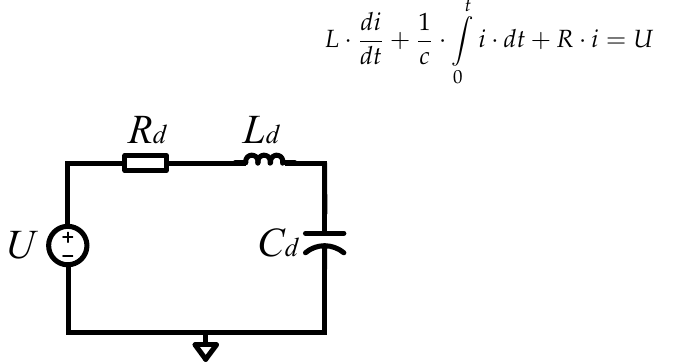
Figure 3. Equivalent electrical model of MEMS gyroscope.